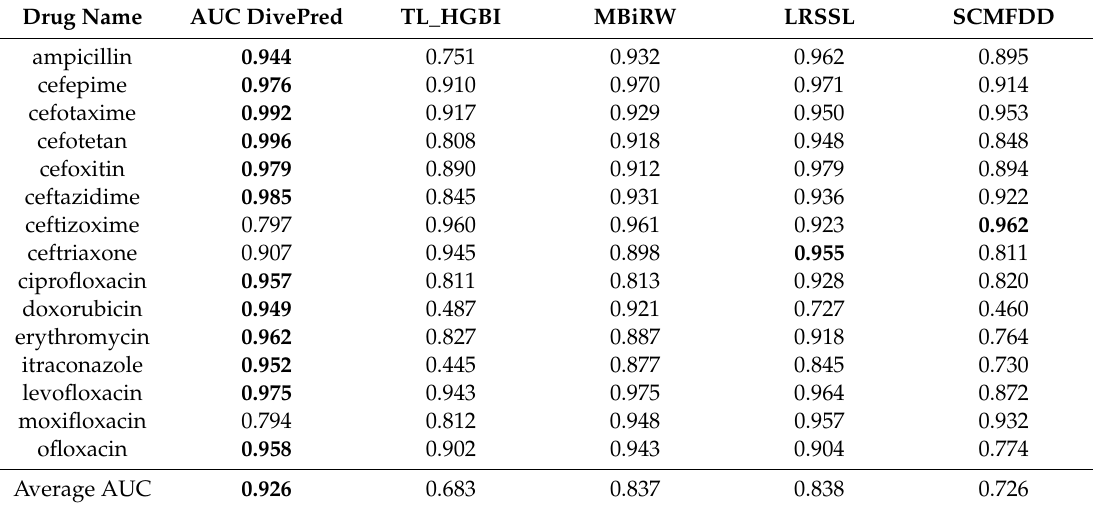
Figure 1. Two types of curves for evaluating the predicting performance of DivePred and other methods. Table 1. Area under ROC curve (AUC) values of 15 drugs using DivePred and other methods.